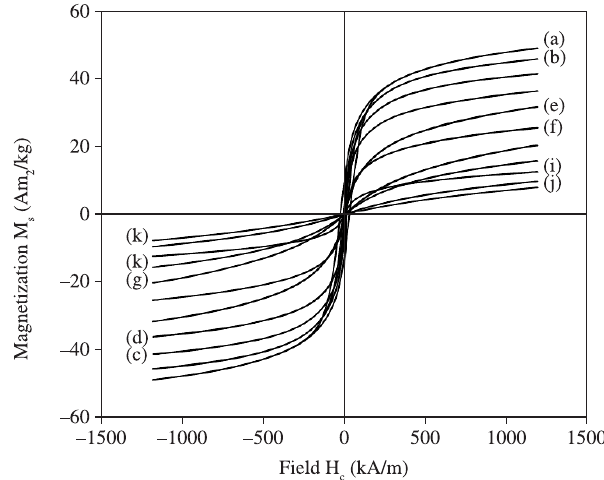
Figure 2. Variation of Lattice constant (a Ni Zn Fe O with x varying from 0 to 1.0. 1-x x 2 4